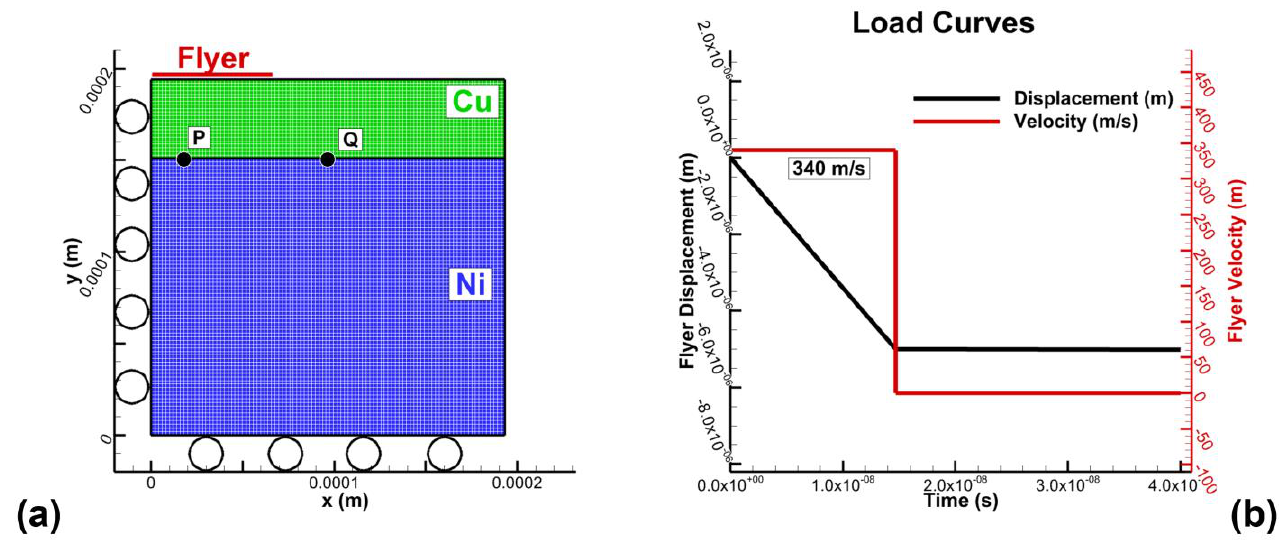
Figure 5. ( a ) Representation of the FE mesh that is subjected to the displacement load curves illustrated in ( b ) with a constant speed of 340 m/s for 14.73 ns.